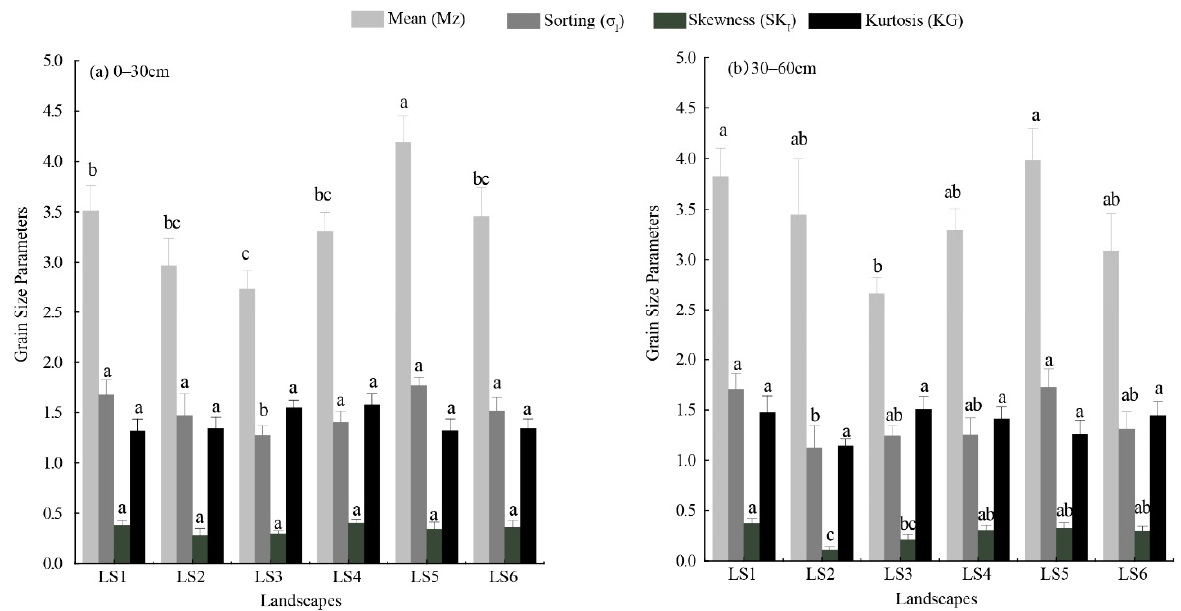
Figure 4. Change characteristics of grain size parameters of sediments collected from different landscapes (different letters above the bars indicate significant differences between parameters ( p < 0.05). Mz denotes mean grain size, σ I denotes standard deviation, SK I denotes skewness, KG denotes kurtosis.).